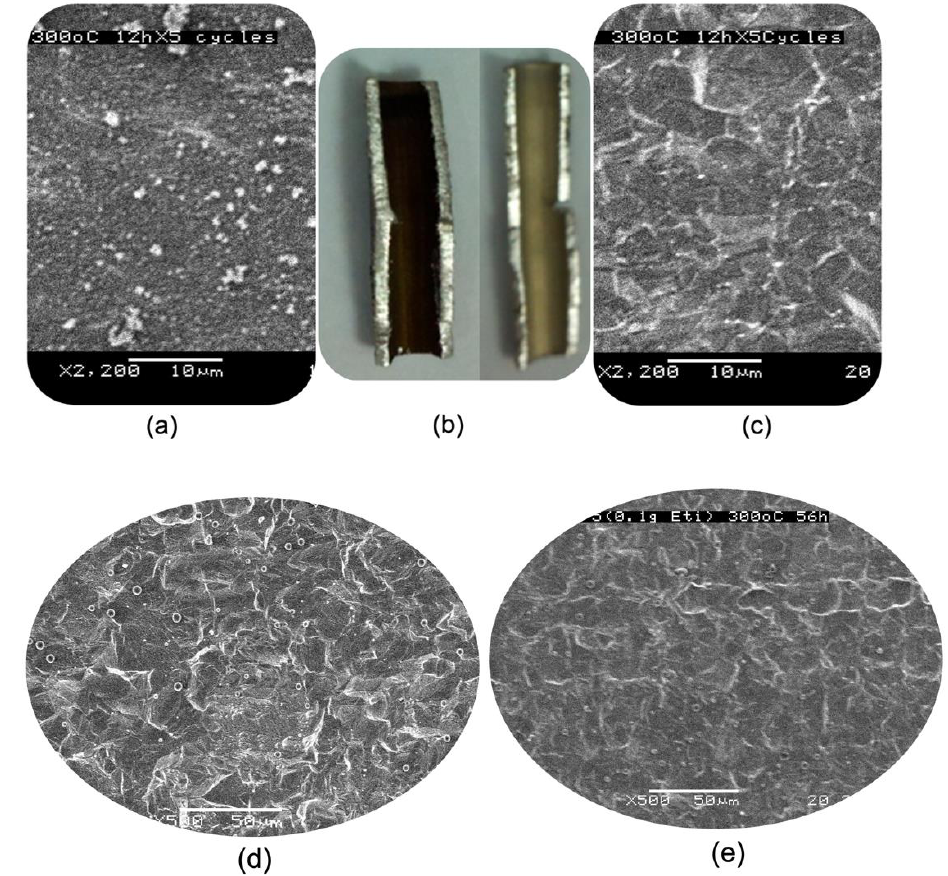
Figure 7. Examination of coking extents occurring in two sets of selected sample tubes: ( a ) the SEM image of tube C and ( c ) that of tube LHC-E after the five-heating cycle (5 × 12 h) test (Section 2.3) and ( b ) the photos of the above two samples; ( d ) the SEM image of sample tube LHC-E and ( e ) that of LHC-E/c after a single heating cycle at 300 °C for 56 h. The scale bars are 50 μ m in ( d , e ).